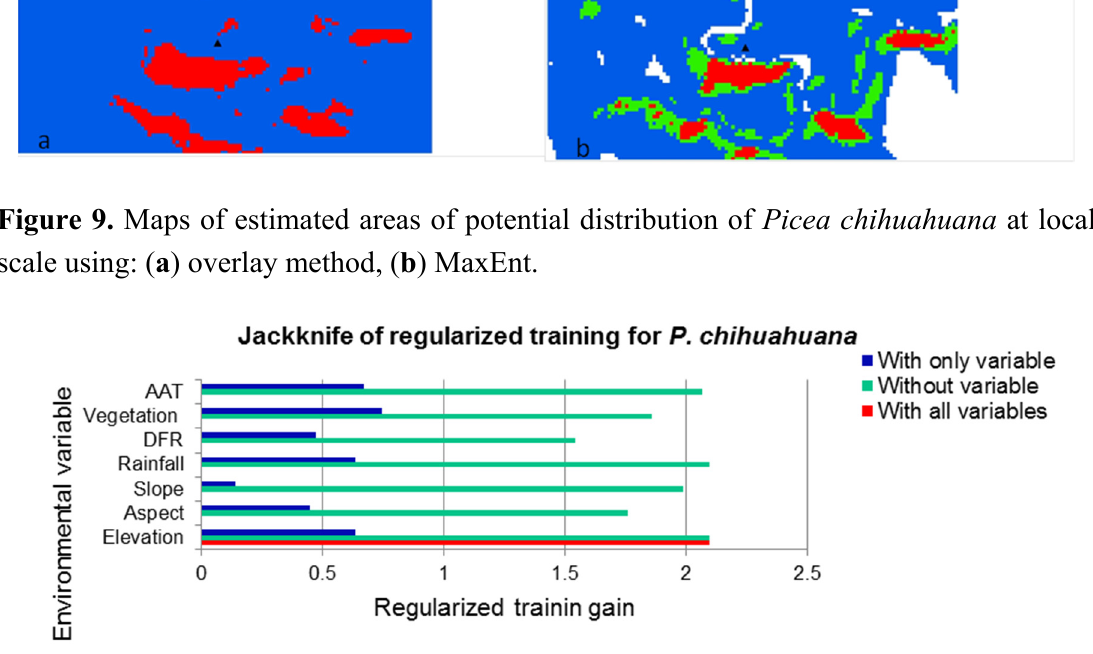
Figure 10. Jackknife of regularized training gain for Picea chihuahuana Martínez at local scale. AAT = Annual Average Temperature and DFR = Distance to water